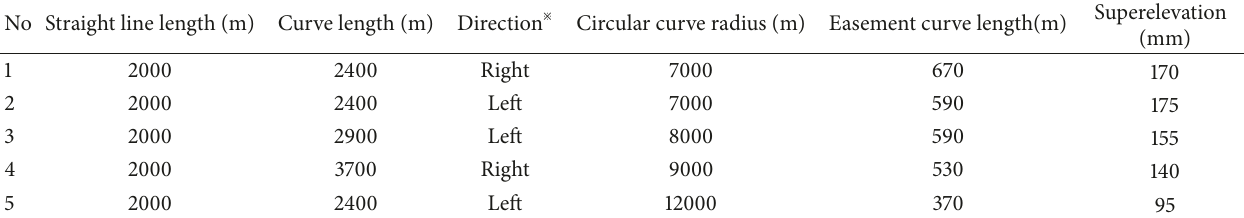
Table 1: Linear distribution and line parameters of a high speed railway.